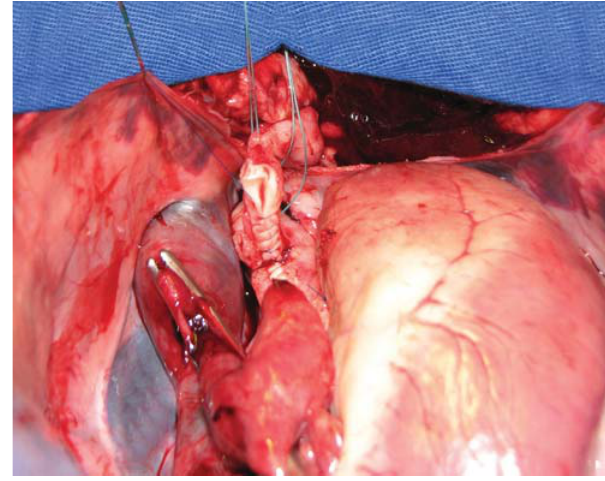
Figure 2 - Distal end of graft, ready for anastomosis with bridging vessel